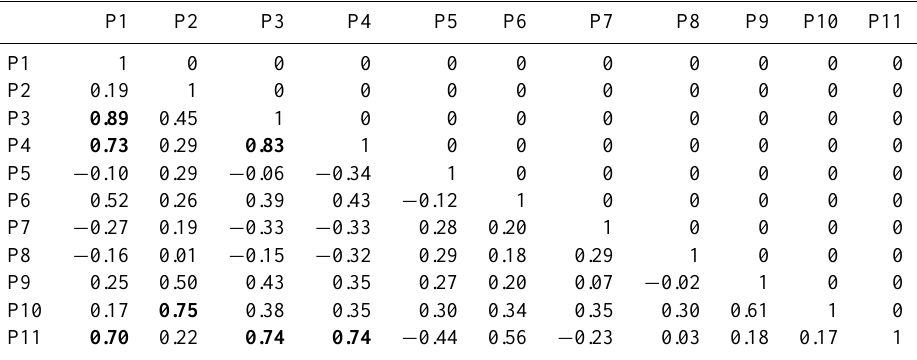
Table 3. Pairwise Pearson correlations values between the peak intensities identified in the 21 EEMs after the deconvolution. Values in bold represent the significant correlations ( P < 0.001, d.f. =